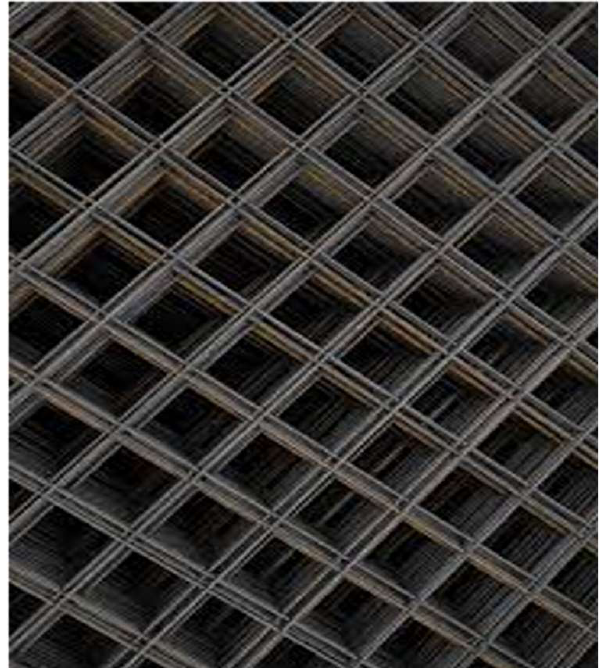
Figure 2. Welded Steel wire Mesh.